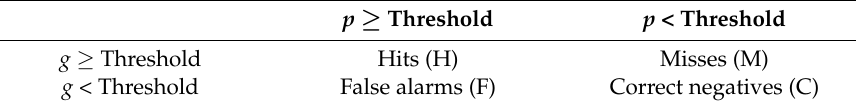
Table 2. Contingency table for comparing individual precipitation products ( p ) with the hydrological precipitation observations ( g ). The rainfall thresholds in this paper are 0.1, 1.0, 5.0, 10.0, 20.0, 30.0, 40.0 and 50.0 mm/6